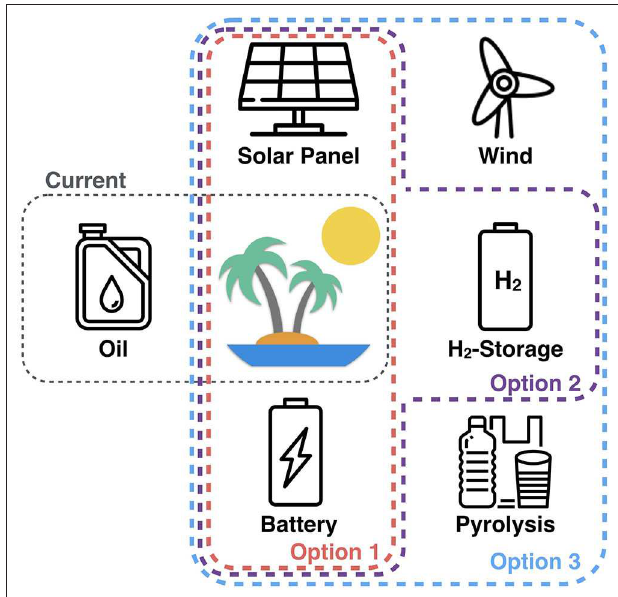
FIGURE 1 | Illustration of the different options